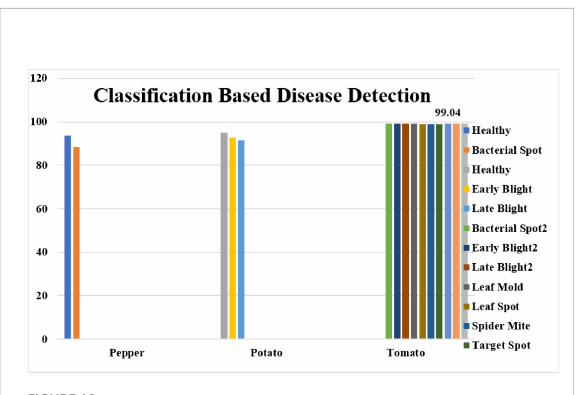
FIGURE 10 Performance Comparison of the proposed deep learning model for pepper, potato, and tomato plant disease detection.